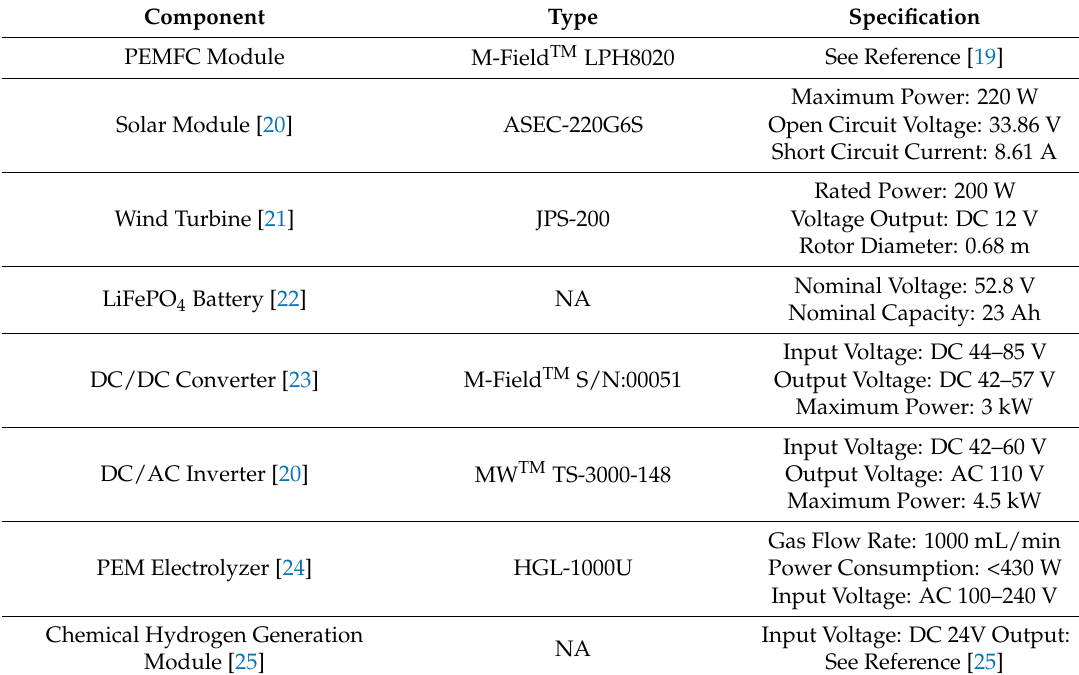
Figure 1. The general hybrid power system. Table 1. Specifications of the hybrid system [19–25].